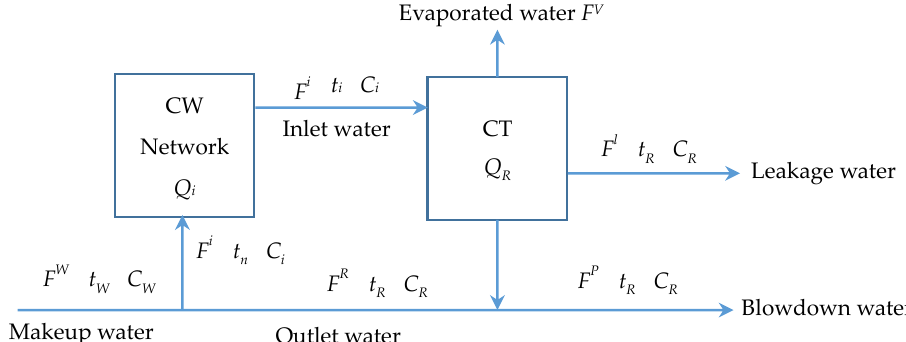
Figure 1. Physical model of open circulating cooling water system.